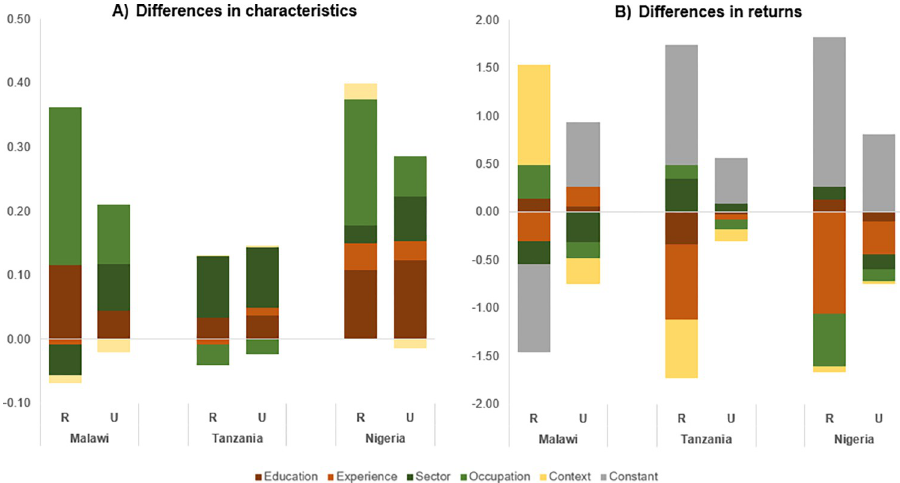
Fig 2. Detailed decomposition of average gender pay gap (in log points) in non-farm employment, identifying the relative contributions of gender differences in observable characteristics (Panel A) versus the relative contributions of gender differences in returns to these characteristics (Panel B), across rural (R) and urban (U) areas in Malawi, Tanzania and Nigeria for women and men aged 25–55. Education comprises no, primary, secondary and tertiary schooling; experience comprises experience, its square and multiple jobs; sector comprises mining, manufacturing, electricity/utilities, construction, commerce, transport/storage/communication, finance/real estate, other services and missing sector; occupation comprises self-employed with/without family labor, low-skilled/medium-skilled/high- skilled wage employed; context comprises region, proxy respondent, enumerator and month of interview; and constant comprises all unexplained differences. Results are obtained from regressions presented in Table 4. Population statistics are corrected using sampling weights. The number of observations for the different bars are as follows: 3,156; 2,593; 1,592; 1,814; 2,285; 1,515. Fig 2 decomposes the gender pay gap further (with more detailed regression results in Table 4). Panel A presents the contributions of gender differences in observable characteristics to the gender pay gap, while Panel B demonstrates the contributions of gender differences in returns to these characteristics. The contributions can take on both negative and positive val- ues, decreasing or exacerbating the gender pay gap, respectively.